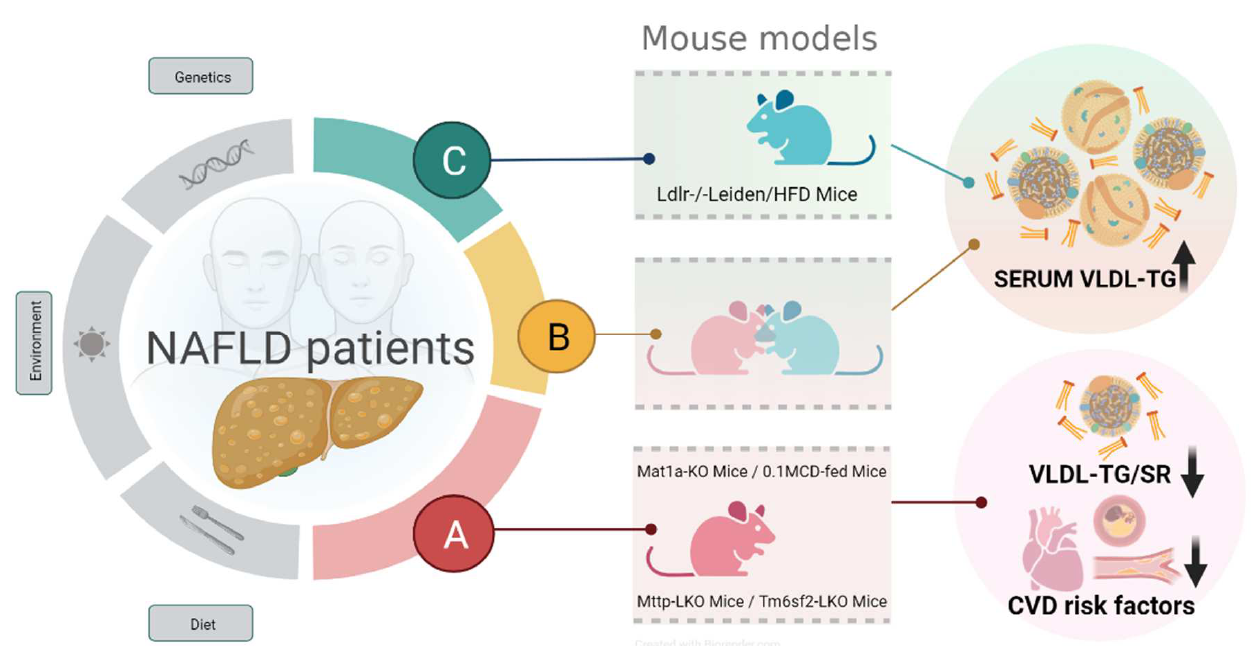
Figure 2. NAFLD patients subtypes in relation with murine models and CVD risk. Metabolomics analysis of serum allows classifying NAFLD patients into subtype A, B, or C by comparison with metabolomes of five mice models. Subtype A phenocopies the serum metabolome of four mice with impaired VLDL-TG secretion (Mat1a-KO, 0.1MCD, Mttp-LKO, Tm6sf2-LKO), while subtype C phenocopies the metabolome of Ldlr-/-Leiden/HFD mice. Subtype B showed an intermediate signature. NAFLD subtypes align with CVD risk factors, with subtype A exhibiting a reduced CVD risk. Created with BioRender.com. Table 2. Predictive metabolic signature for the classification of patients with NAFLD into subtypes A, B, and C. For each subtype, symbols indicate deviations from the mean NAFLD value (+ above mean; − below mean; = almost equal). Each negative/positive symbol represents up to 0.4 standard deviations decrements/increments from the mean. Lipid Class Lipid